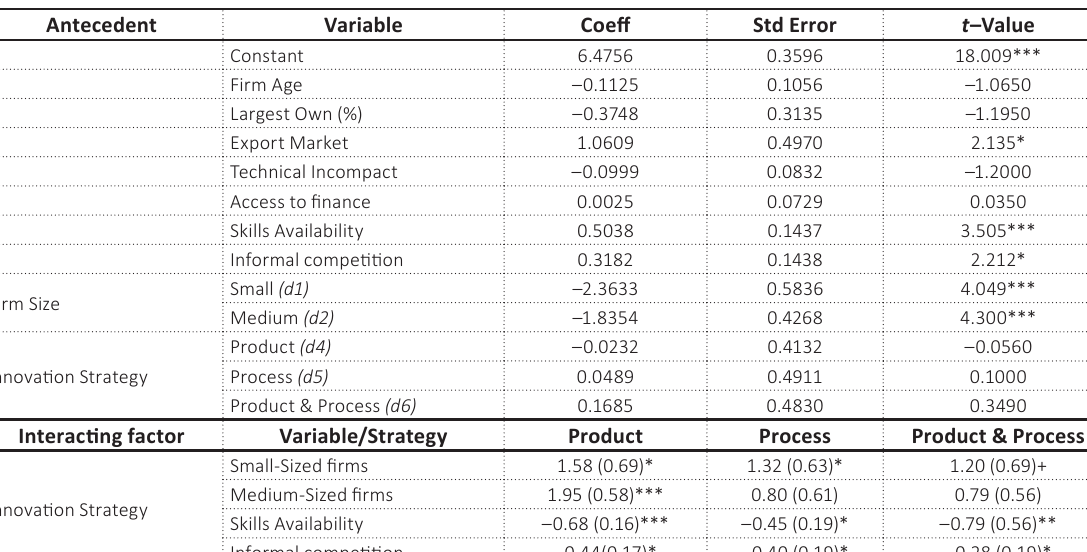
Table 7. Robustness check of the determinants of the R&D cost